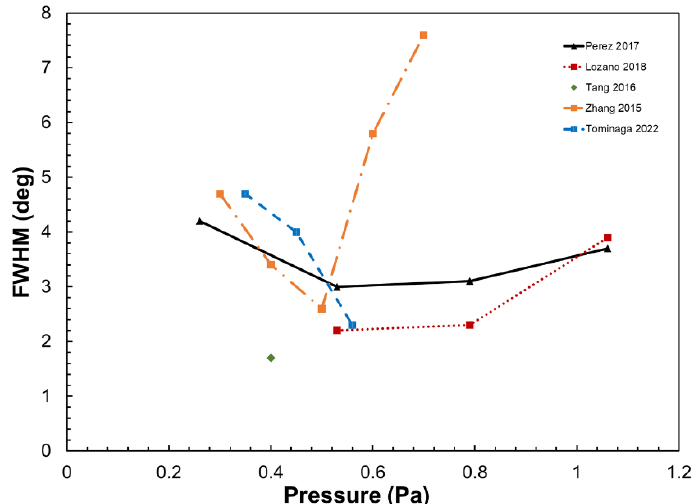
Figure 3. Rocking curve FWHM of the (0002) reflections of ScAlN thin films under various working pressure conditions. pressure